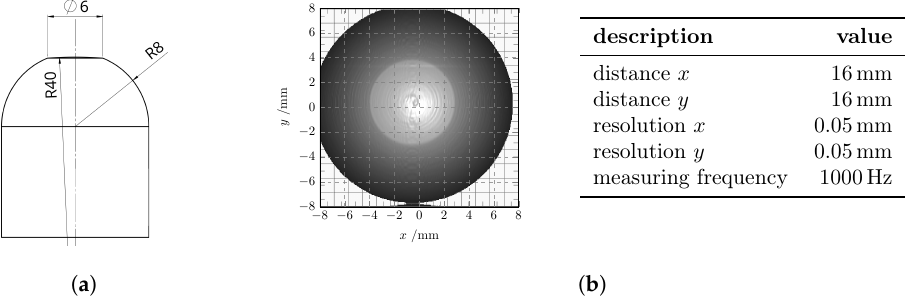
Figure 6. ( a ) Geometry parameters for used electrodes according to DIN EN ISO 5821 F1-16-20-40-6; ( b ) chromatic confocal microscope measurement after initial electrode tip dressing with parameters for topographical measurements.